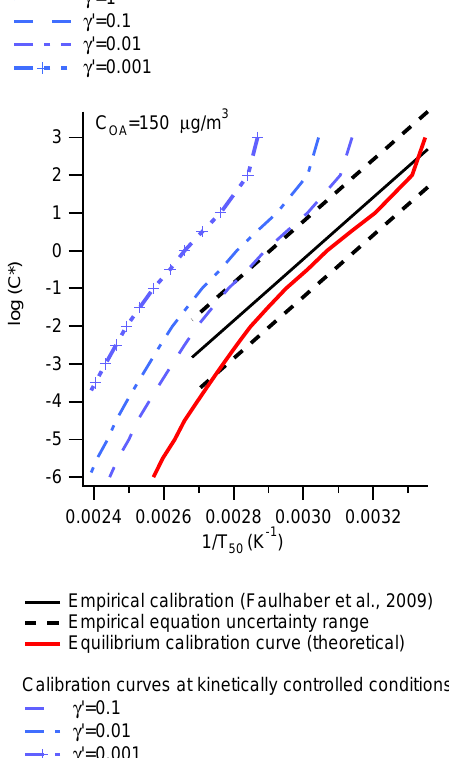
Fig. 12. Deviation of the calibration curve due to equilibrium not being attained in thermodenuder measurements at two differ- ent aerosol loadings. T 50 deviations up to ∼ 20–30 ◦ C, with respect to equilibrium, situate the calibration curve within the uncertainty region of the empirical formulation. Further difference with respect to equilibrium (particularly for γ 0 < 0.01) leads to significant de- viation of the calibration curve with respect to the empirical and theoretical